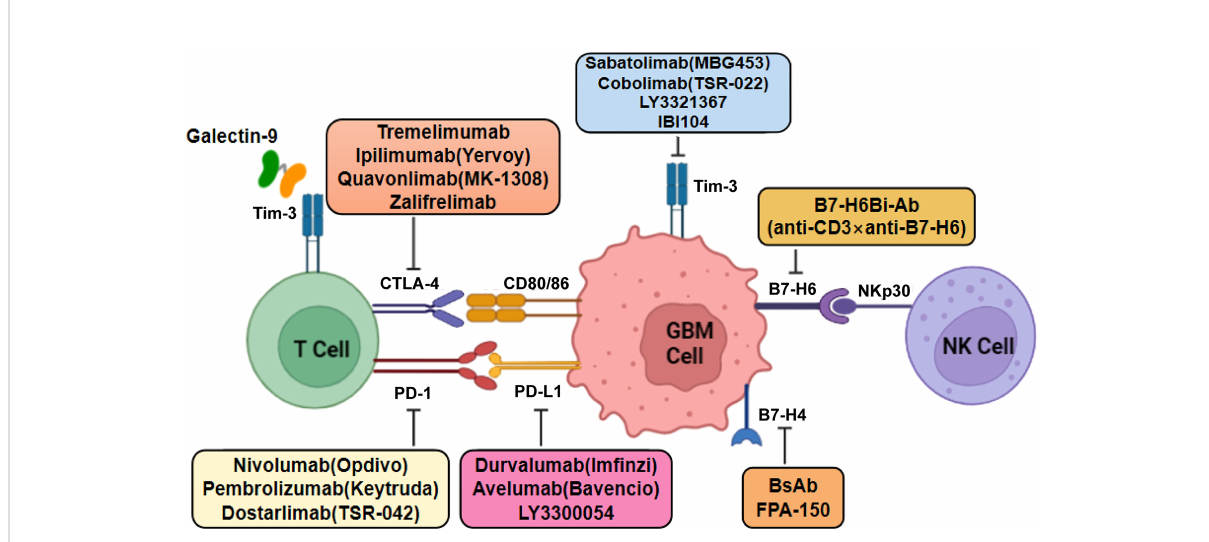
FIGURE 3 Mechanistic model of the action of monoclonal antibodies against immune molecules in GBM therapy. Classical immune checkpoints such as CTLA-4, PD-1, B7-H6, B7-H4, and TIM-3 bind to their ligands to inhibit T-cell activation and proliferation, thereby creating an immunosuppressive microenvironment. Blocking these immune checkpoint molecules by single or combination therapy with monoclonal antibodies may serve as a potential treatment for